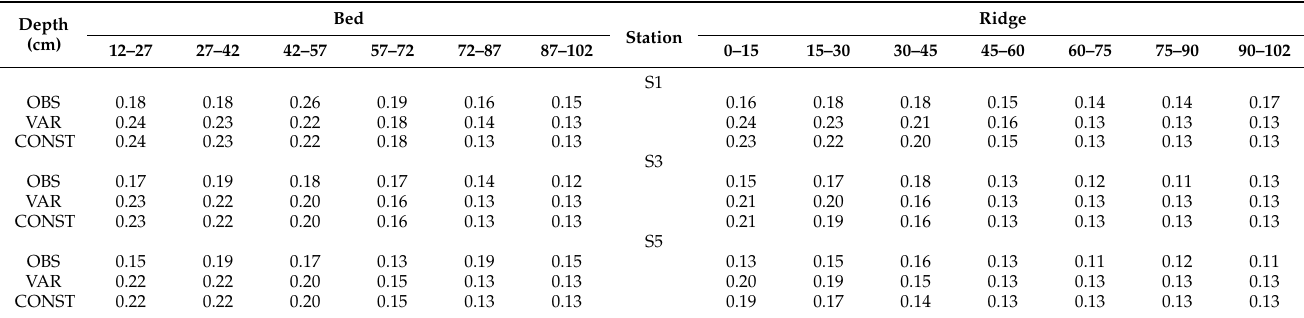
Figure 3. Simulated soil wetting patterns with variable (VAR) and constant (CONST) ponding depth at stations 1 (S1), 3 (S3), and 5 (S5). Volumetric soil water contents (cm 3 ·cm − 3 ) are denoted by th [-]. Table 5. Observed (OBS) and simulated volumetric soil water content with variable (VAR) and constant (CONST) ponding depth at a station.